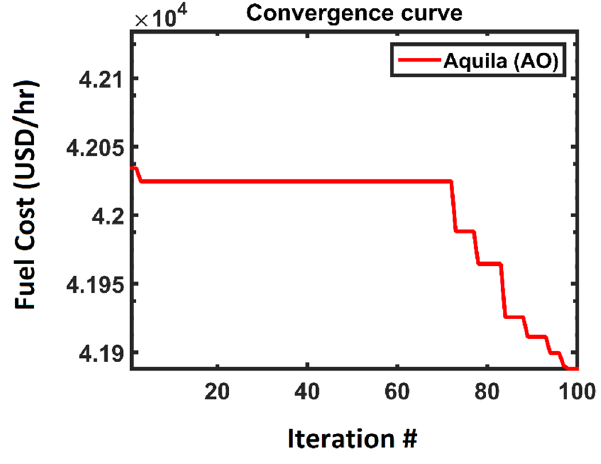
Figure 7. Convergence curve for IEEE-57 bus system using AO.